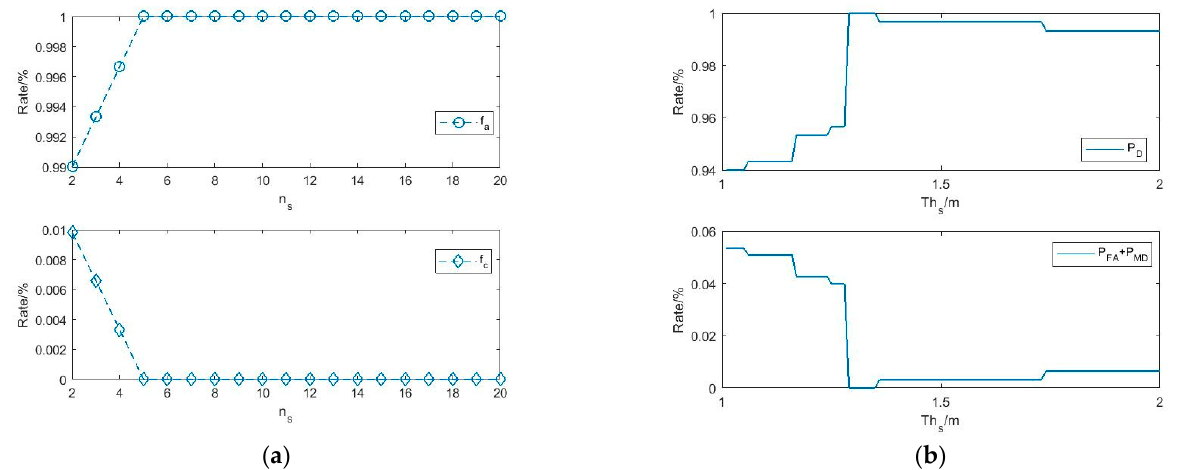
Figure 11. The influence of slow-change parameters on accuracy rate, false alarm rate and missing alarm rate.